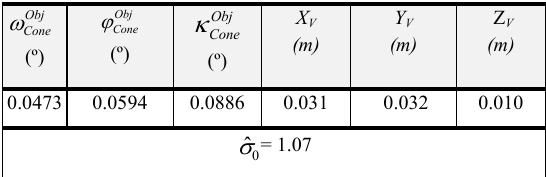
Table 3: Estimated standard deviations of the transformation parameters from the cone to the object space and the sigma